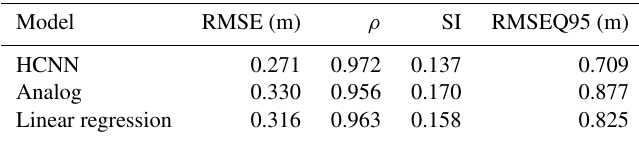
Table 2. Scores of H s prediction by the three methods at node no. 7818.